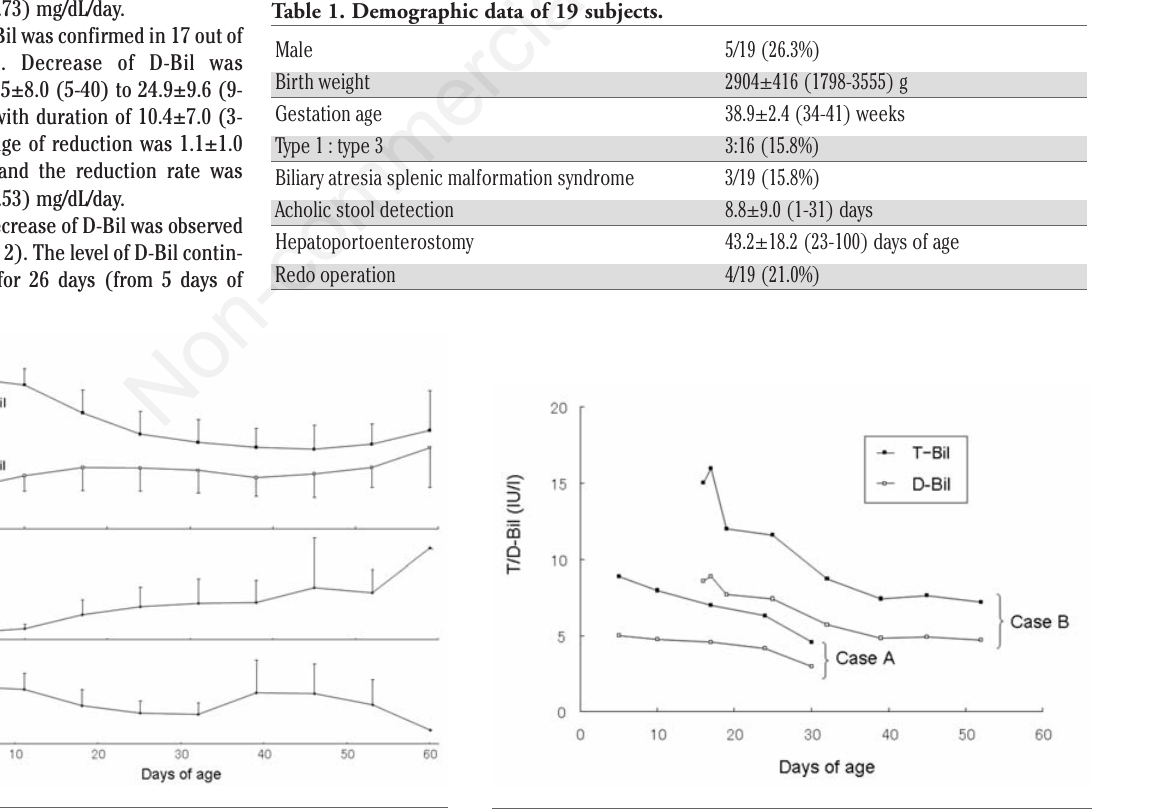
Figure 1. The levels of total bilirubin (T-Bil), direct bilirubin (D- Bil), alanine aminotransferase (ALT) and gamma-glutamyl transpeptidase (gGTP) . Each point represents the average with standard deviation of all the data collected around the 7 days.